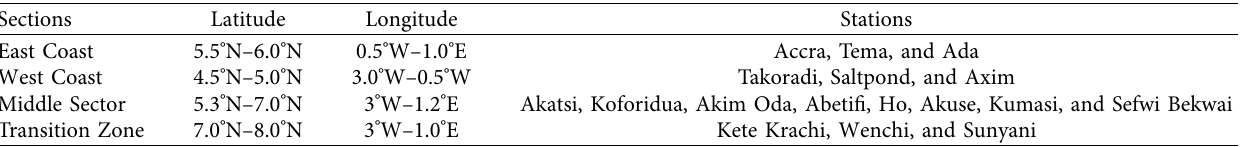
Table 1: Rainfall station